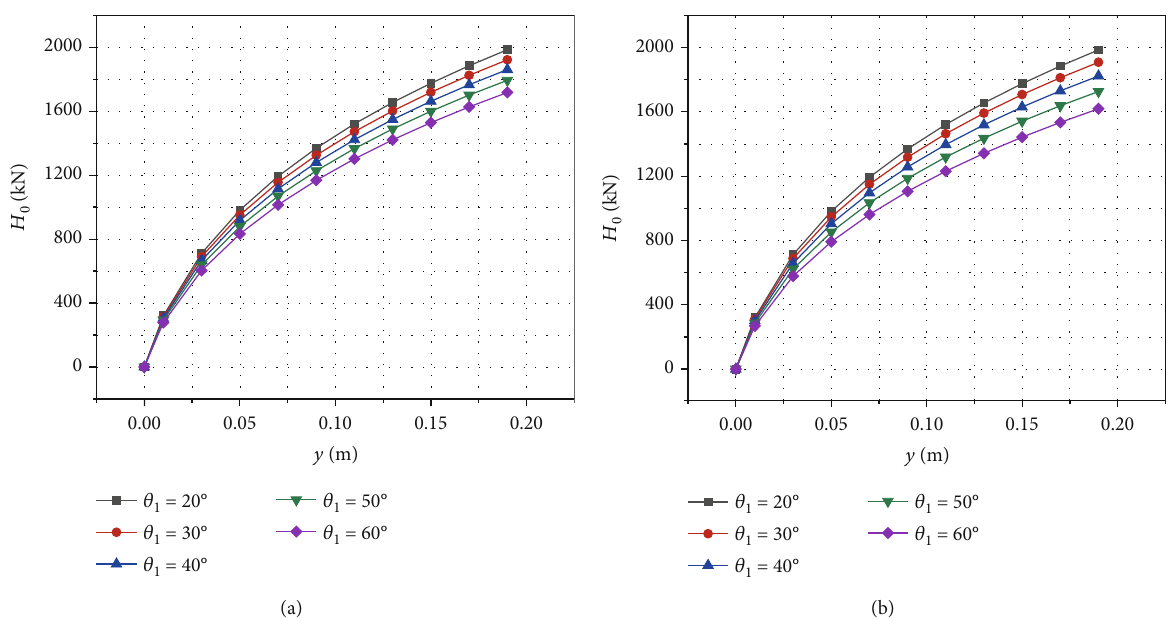
Figure 15: Load and displacement curve of pile head under the e ff ect of θ